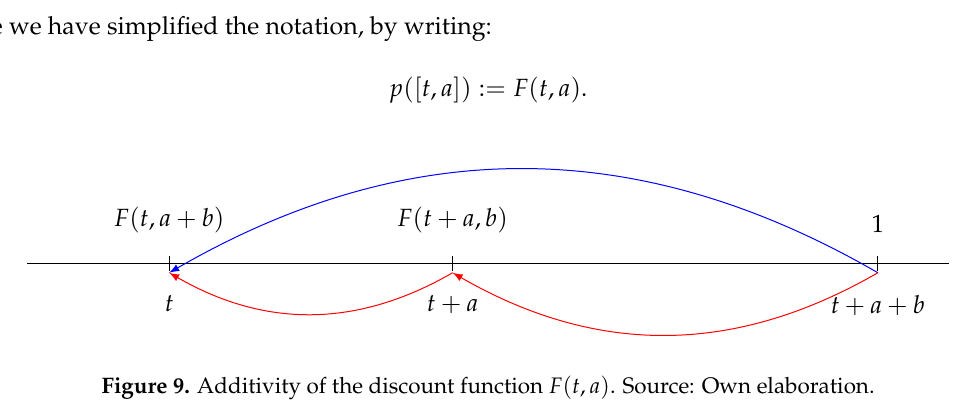
Figure 9. Additivity of the discount function F ( t , a ) . Source: Own